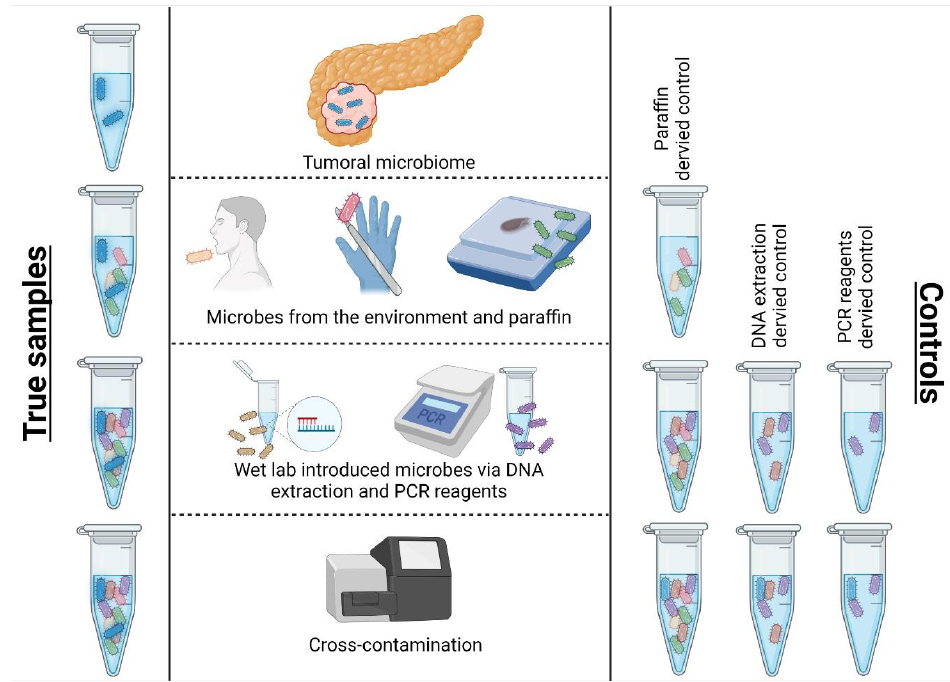
Figure 1. Sources of contamination and recommended controls in tumoral microbiome analysis. Microbial contamination during sample preparation is impossible to avoid. Considering the low biomass of tumor microbiomes, contaminants from the environment, paraffin (in case of FFPE sam- ples), reagents from DNA extraction kits, PCR, and library preparation can outnumber the real tu- mor-derived microbial count. Thus, a thorough decontamination protocol should be mandatory. Ideally, negative controls are implemented at each processing step for every single sample batch. However, real tumoral taxa can also occur in negative controls due to computational cross-contam- ination. Here, an index switch in multiplexed analysis is introduced by sequencing errors (barcode leakage). Desoxyribonucleic acid (DNA), polymerase chain reaction (PCR), formalin-fixed paraffin- embedded (FFPE).